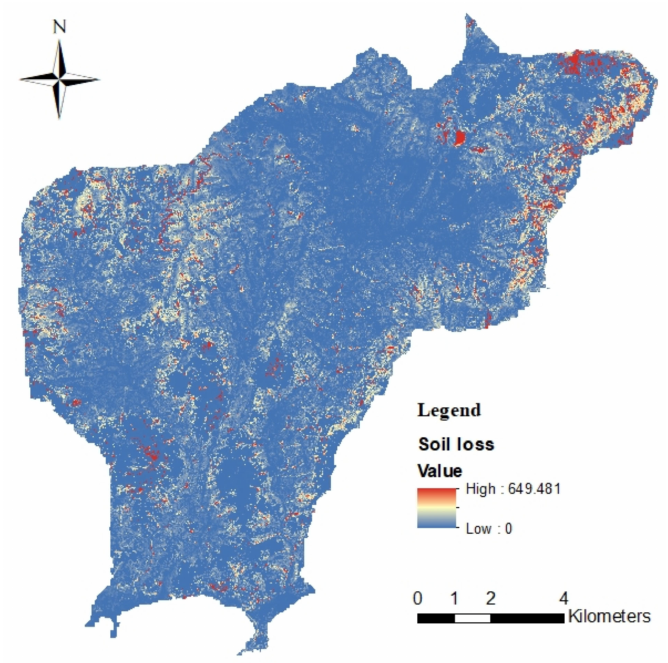
Figure 18. Soil loss map produced using R from the Global Precipitation Measurements (GPM) and C from NDVI -derived Fractional Vegetation Cover(FVC)